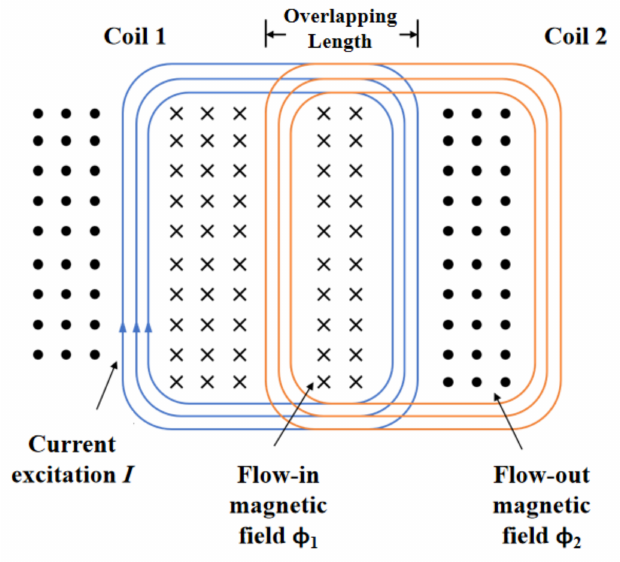
Figure 6. Magnetic coupling structure.